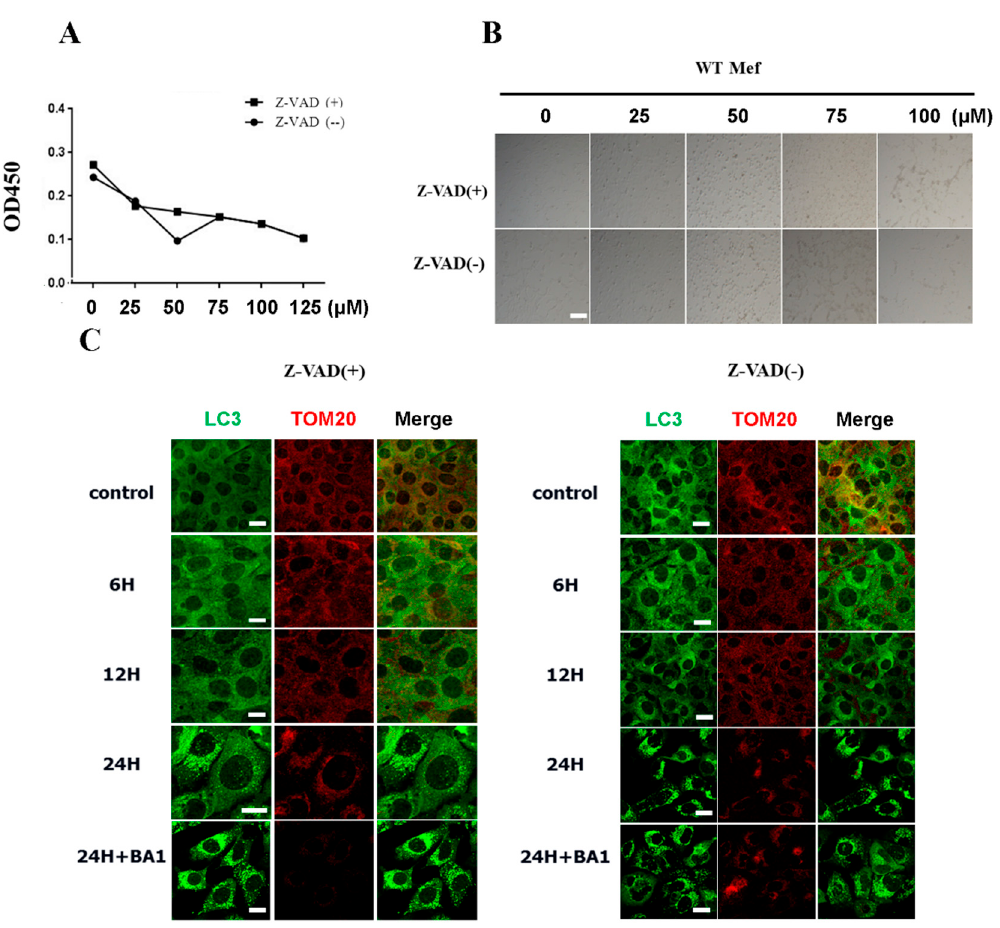
Figure 5. Cisatracurium promotes cell death even in the presence of the apoptosis inhibitor zVAD. ( A ) WT MEFs were incubated with cisatracurium (0, 25, 50, 75, 100, or 125 µM) for 12 h in the ( A ) WT MEFs were incubated with cisatracurium (0, 25, 50, 75, 100, or 125 µ M) for 12 h in the presence presence or absence of apoptosis inhibitor Z-VAD (50 µM). Cell viability was analyzed by CCK8 or absence of apoptosis inhibitor Z-VAD (50 µ M). Cell viability was analyzed by CCK8 assay; ( B ) WT assay; ( B ) WT MEFs were incubated with cisatracurium (0, 25, 50, 75, or 100 µM) for 12 h in the MEFs were incubated with cisatracurium (0, 25, 50, 75, or 100 µ M) for 12 h in the presence or absence presence or absence of apoptosis inhibitor Z-VAD. Cells were observed by light microscopy. of apoptosis inhibitor Z-VAD. Cells were observed by light microscopy. Bar = 100 µ m; ( C ) WT MEFs Bar = 100 µm; ( C ) WT MEFs were incubated with cisatracurium (10 µM) for 0, 6, 12, or 24 h in the were incubated with cisatracurium (10 µ M) for 0, 6, 12, or 24 h in the presence or absence of Baf A1. presence or absence of Baf A1. Cells were stained by anti-LC3 (green) and anti-TOM20 (red) antibody. Cells were stained by anti-LC3 (green) and anti-TOM20 (red) antibody. Bar = 20 µ Bar = 20 µm.